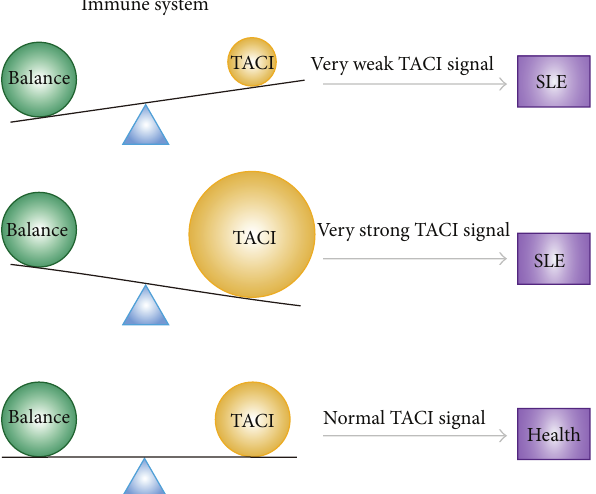
Figure 4: Conjectured relations between TACI signal intensity and immune system balance. Overly strong or very weak TACI signal will disrupt the immune system balance and promote